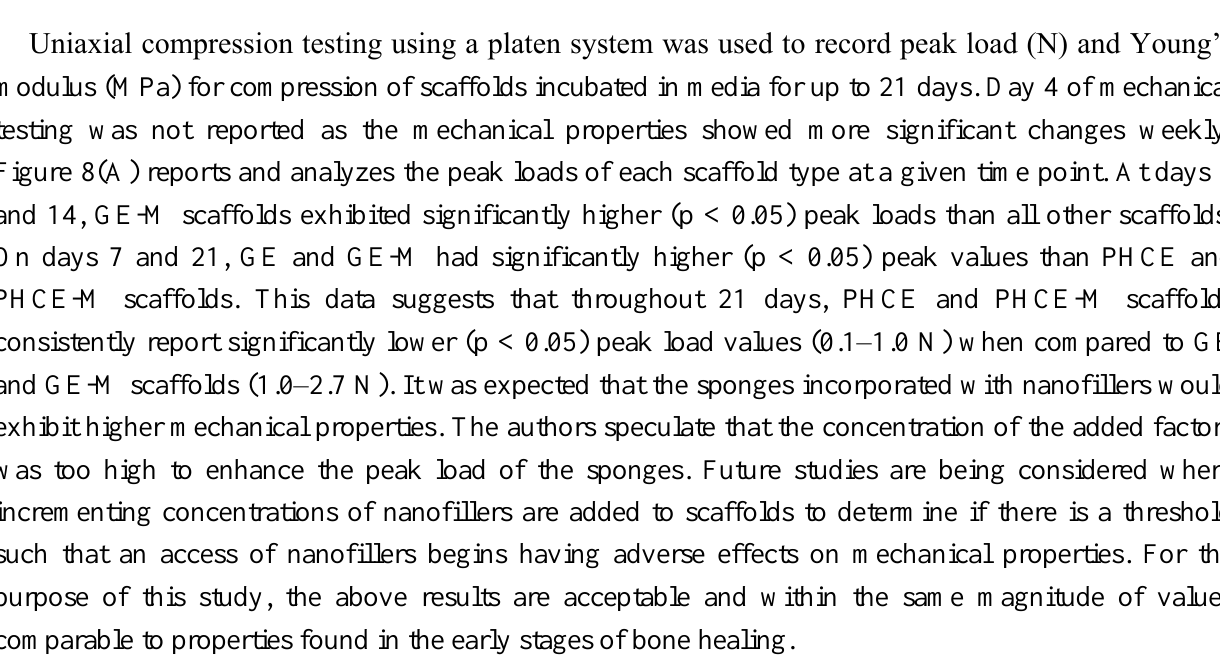
Figure 8. Peak load of scaffolds ( A ) at a given time point and ( B ) over 21 days incubation in media. Over 21 days, PHCE and PHCE-M scaffolds reported lower peak load values than mineralized and non-mineralized gelatin